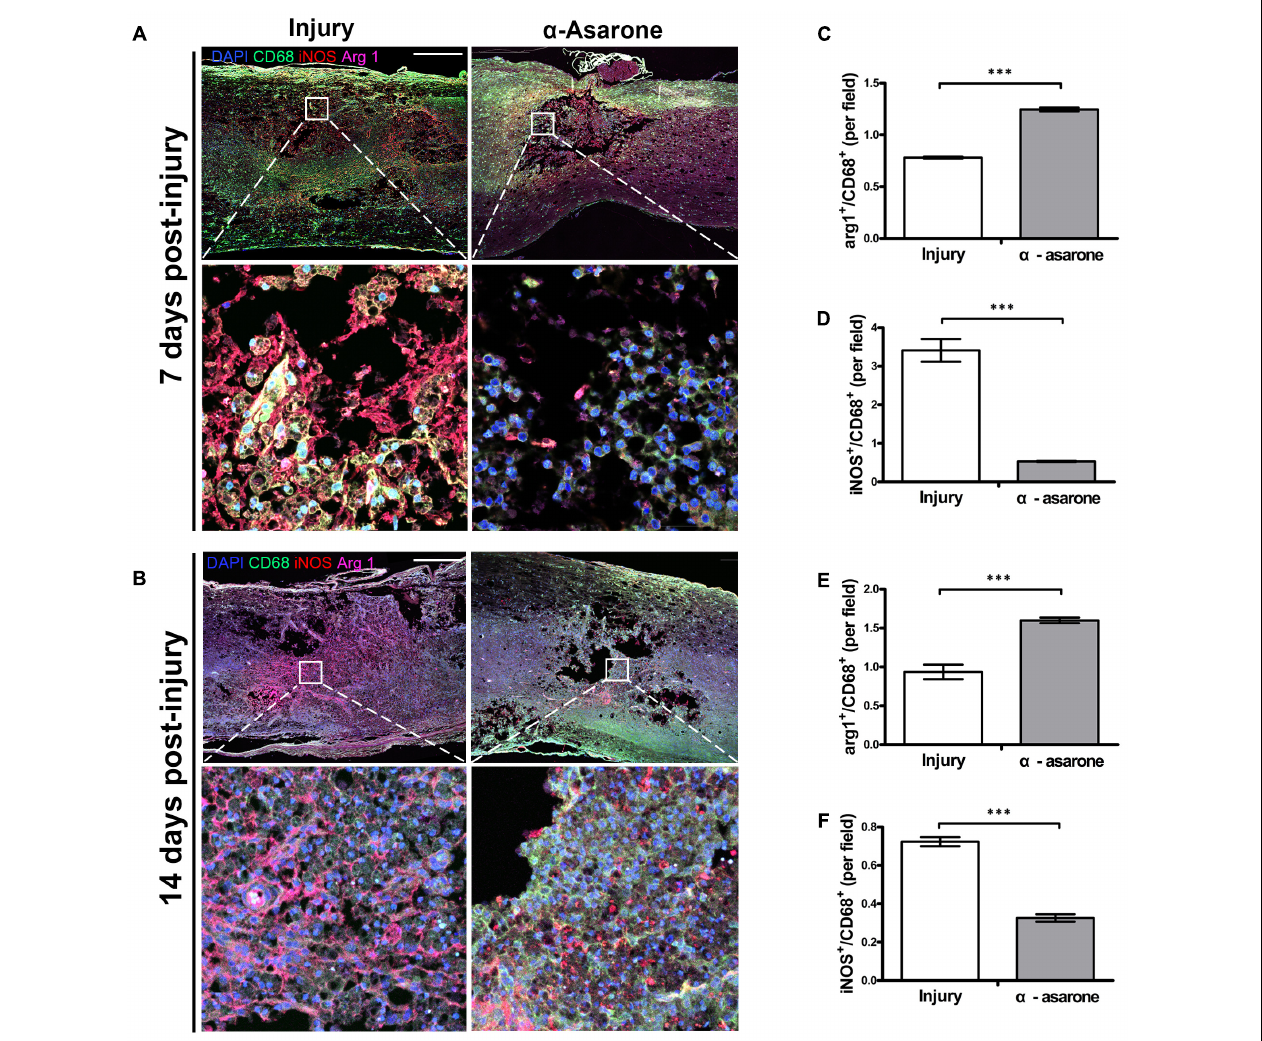
FIGURE 6 | α -asarone triggered M2 macrophage phenotype in vivo . (A,B) Immunolabeling for CD68 (green, microglia, and macrophage maker), iNOS (red, M1 marker), and Arg 1 (purple, M2 marker). DAPI is used for nuclear counterstaining at the lesion site. Scale bars, 5,000 µ m and 50 µ m. (C–F) Semi-quantitative analysis of immunohistochemistry for Arg 1 and iNOS. ∗∗∗ P < 0.001, one-tailed Student’s t -test ( n =